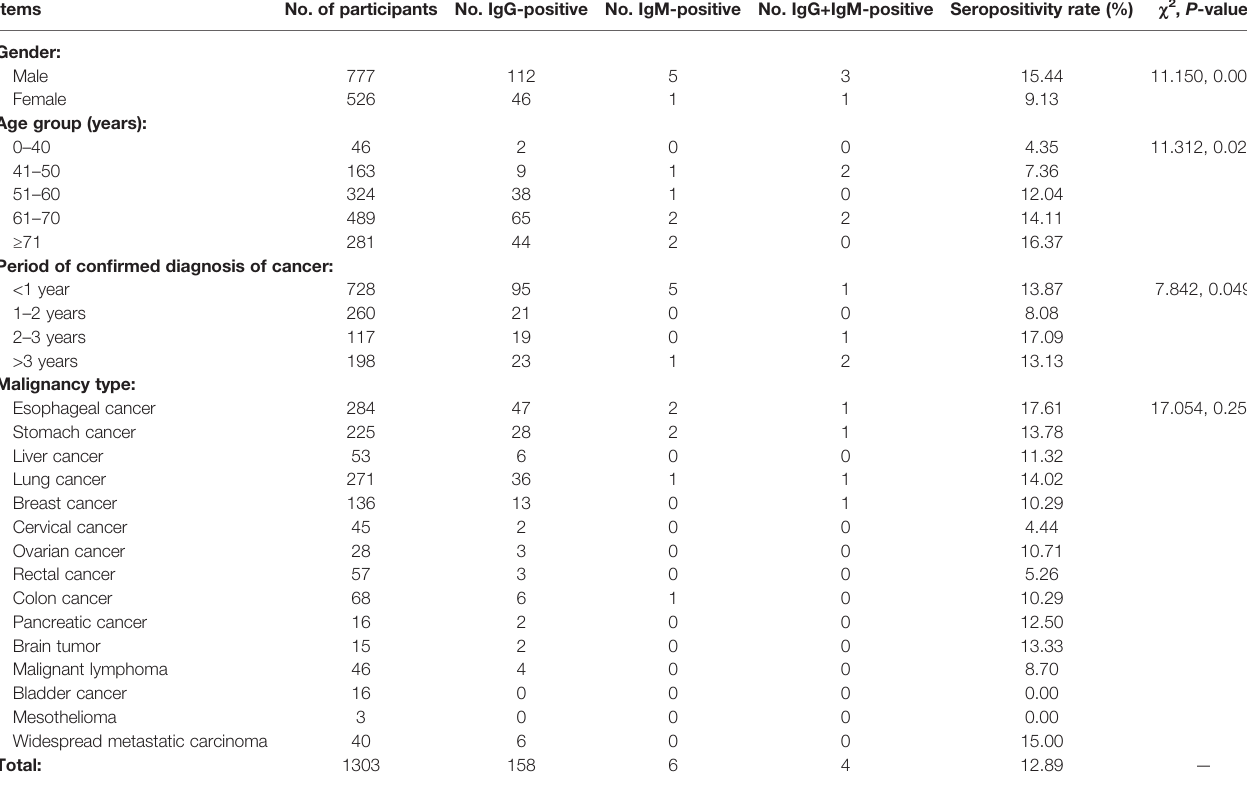
TABLE 4 | Seroprevalence of toxoplasmosis in cancer patients.